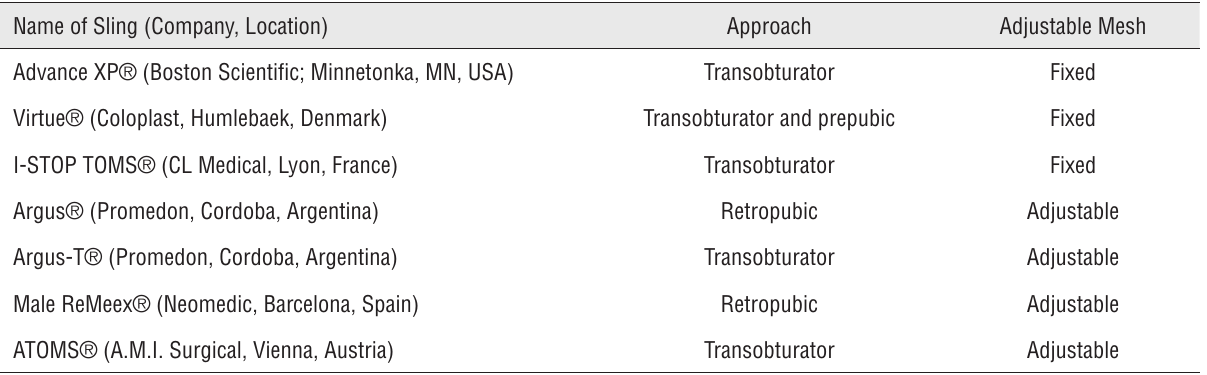
Table 1 - Commercially Available Male Urethral Slings across the World. Name of Sling (Company,